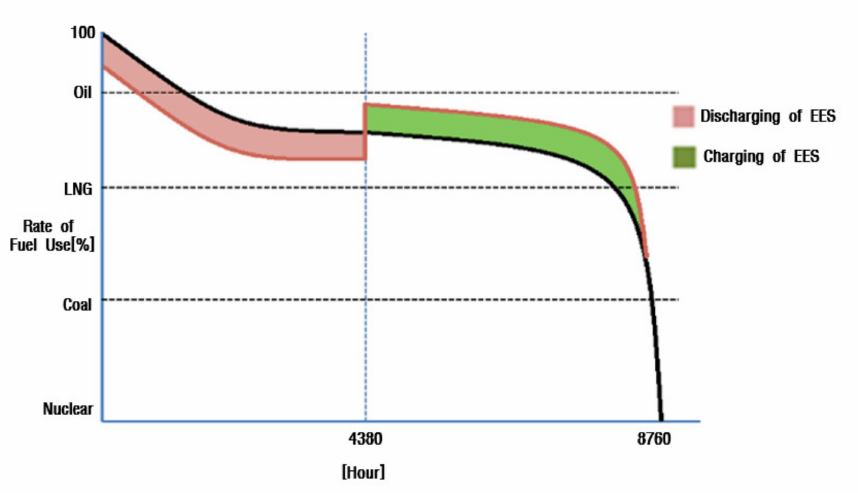
Figure 2. Concept of load duration curve with EES